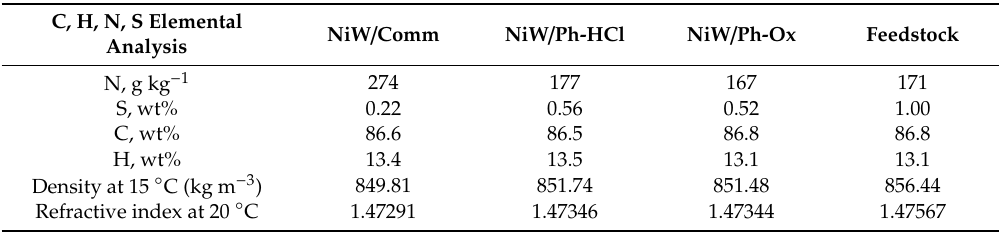
Table 6. C, H, N, and S elemental analysis, density, and refractive index for the organic liquid products of the HDS